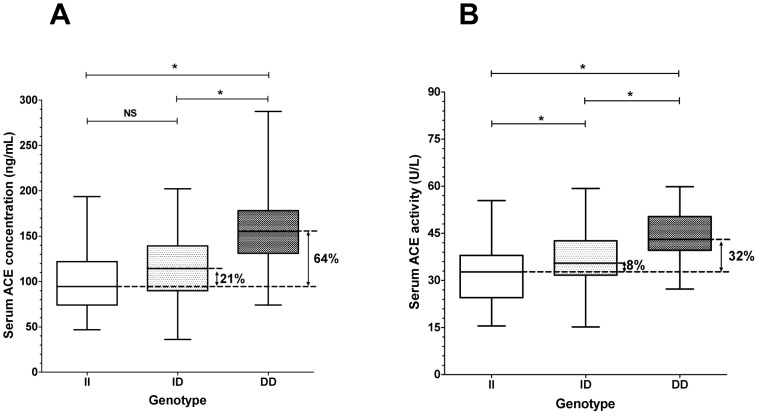
ACE genotype determines serum ACE concentration and activity.Serum ACE concentration, activity and genotype was determined as mentioned earlier (Figs. 3, 1). ACE concentration (A) and activity (B) in patients with different ACE genotypes (insertion, II, n = 28; deletion, DD, n = 52 and heterozygotes, ID, n = 71) are shown. The boxes indicate the interquartile range with median; whiskers are the minimum and the maximum values. Significant differences (1 way ANOVA, Bonferroni post-hoc test) are labelled by asterisks (NS, not significant).